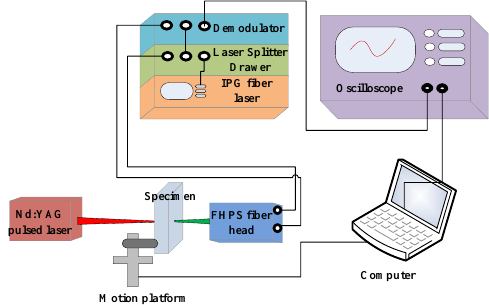
Figure 2. Schematic diagram of experimental system by laser ultrasonics. (Color online).